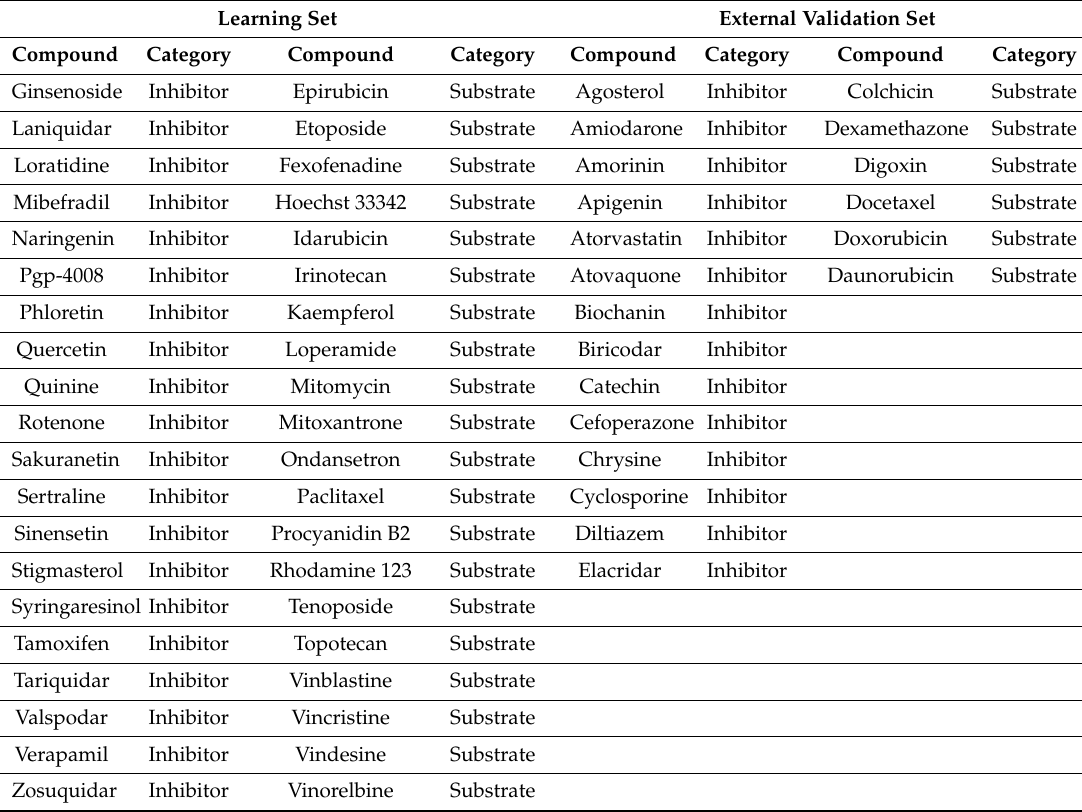
Table 2. Compounds selected for learning and external validation for the P-gp inhibitor / substrate prediction